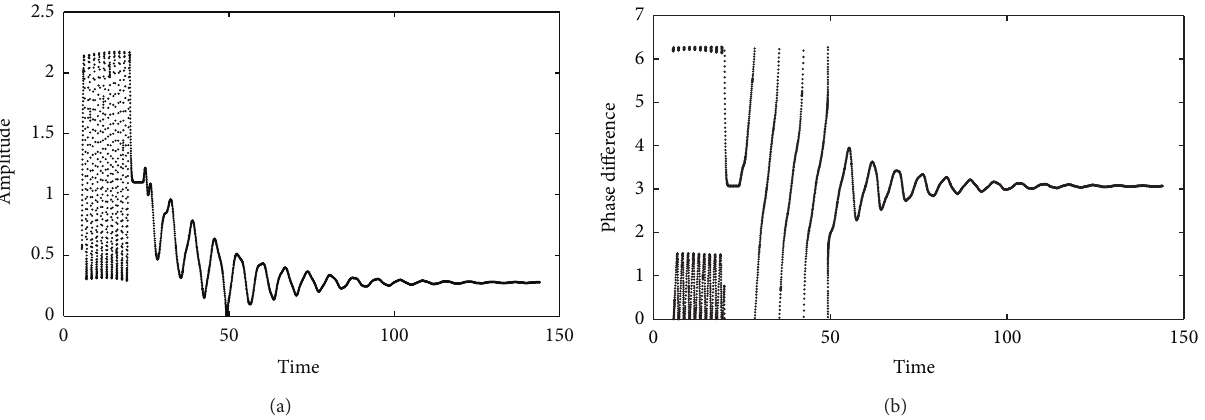
Figure 4: Control result at 𝜔 = 1.9 . Time history of (a) the radial displacement amplitude and (b) phase